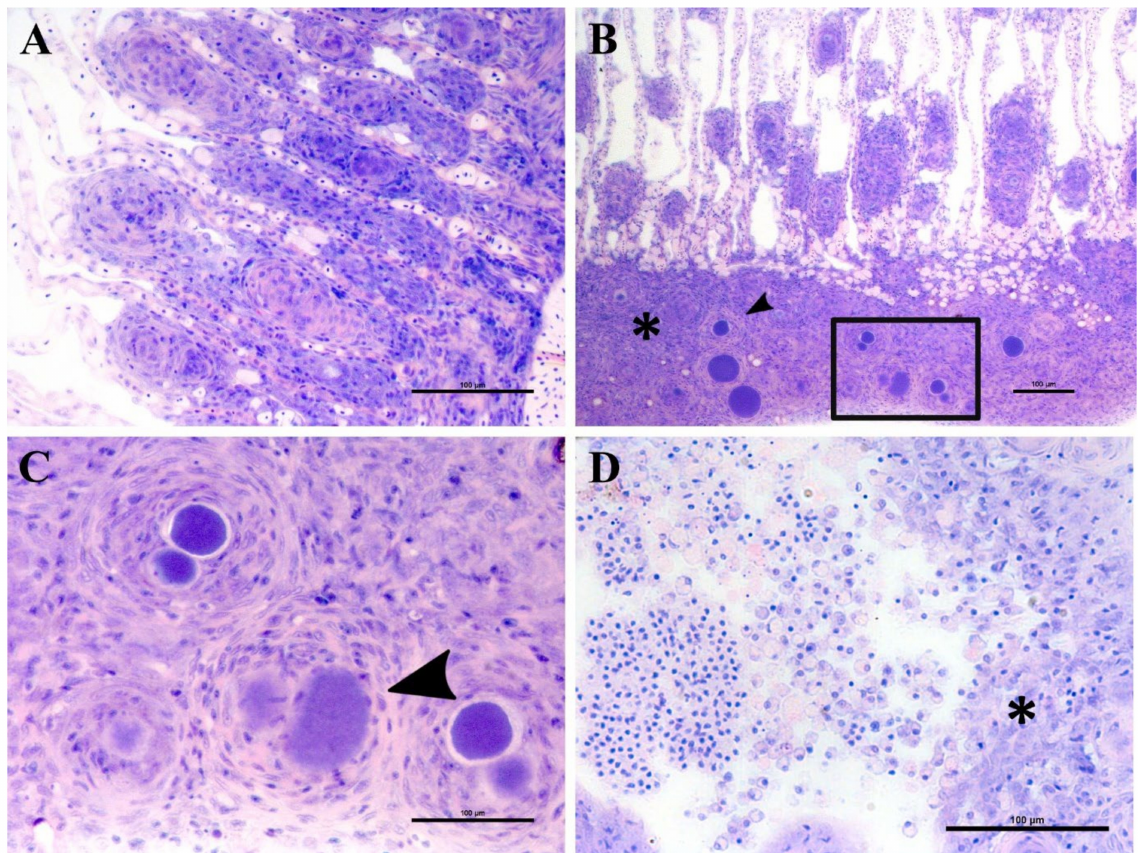
Figure 4. Histological sections of greater amberjack gills from the first outbreak of epitheliocys- tis (cohort 2017); polychrome stain. ( A ) Lamellar fusion (arrow) and extensive obliteration of the interlamellar spaces in a moribund fish. ( B ) Multifocal lamellar fusion (arrow) and extensive hy- perplasic tissue (asterisk) including cysts (arrowhead). ( C ) Detail of hyperplastic area (frame) from ( B ), with‘densely packed cysts and ruptured cysts (arrowhead). ( D ) Macrophages infiltrating a hyperplasic area